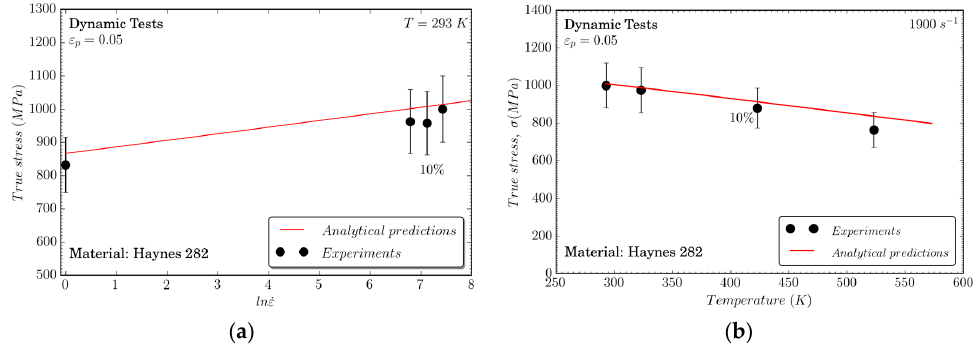
Figure 10. Comparison between the analytical predictions of the constitutive model and experiments at 1900 s − 1 to analyze the influence of ( a ) strain rates and ( b ) temperatures.